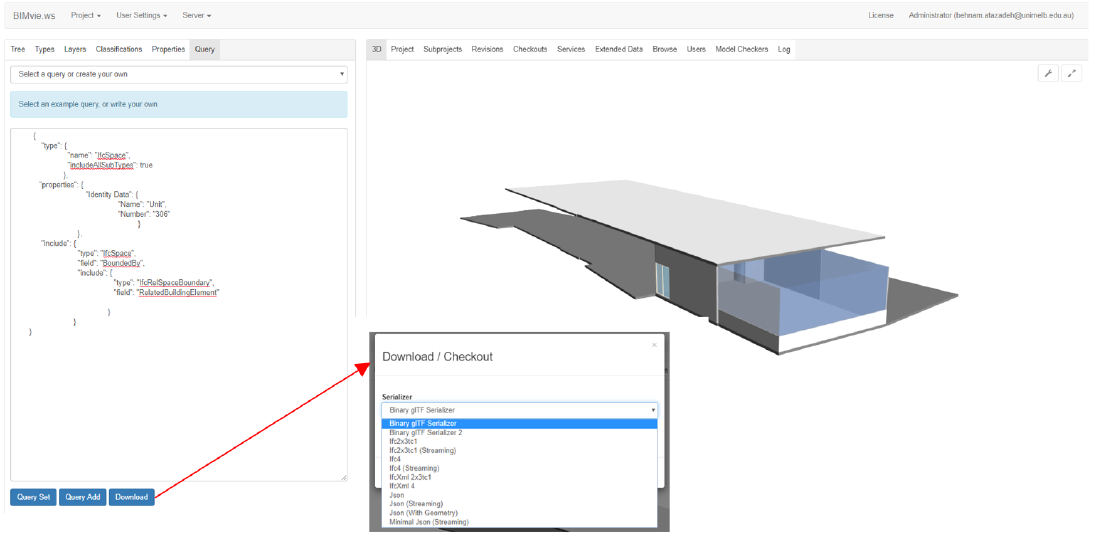
Figure 4. The BIMViews environment for querying the building information modelling (BIM) model with actual input and output.